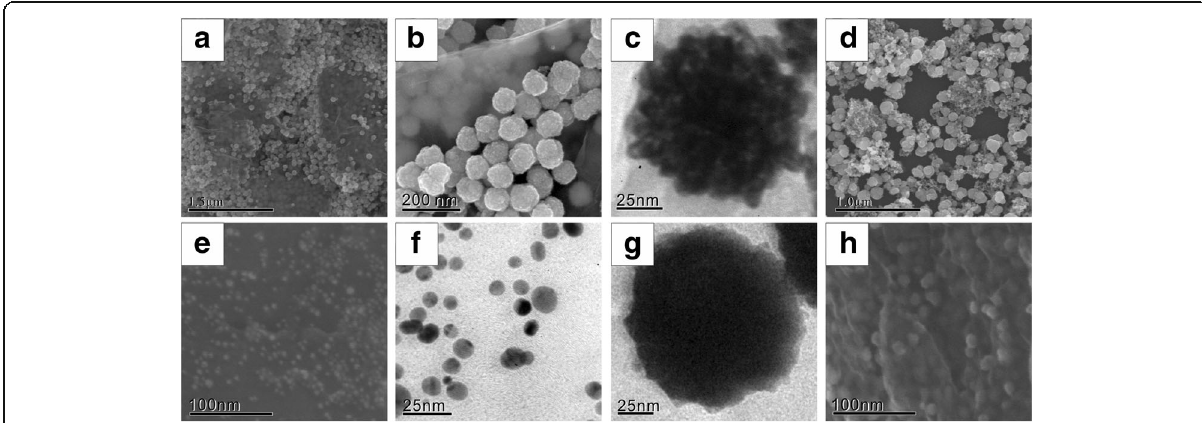
Fig. 1 SEM ( a , b ) and TEM ( c ) images for Pd-Cu (F) /RGO. SEM ( d ) image for Pd-Cu (F) . SEM ( e ) and TEM ( f ) images for Pd-Cu (P) /RGO. TEM ( g ) image for Cu